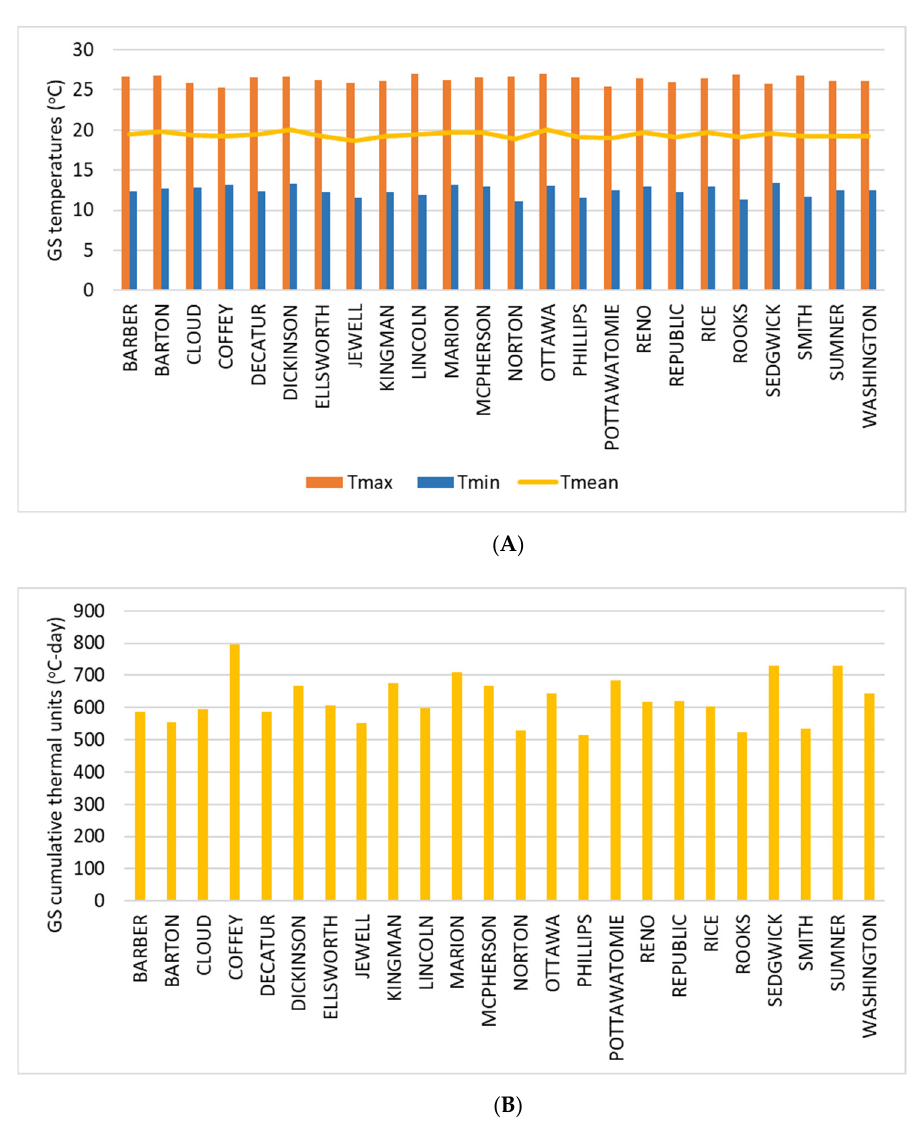
Figure 7. Growing season maximum (Tmax), minimum (Tmin), and mean (Tmean) temperature ( A ), and cumulative thermal units ( B ) of selected counties in Kansas over the period of 30 years (1988 to 2017).